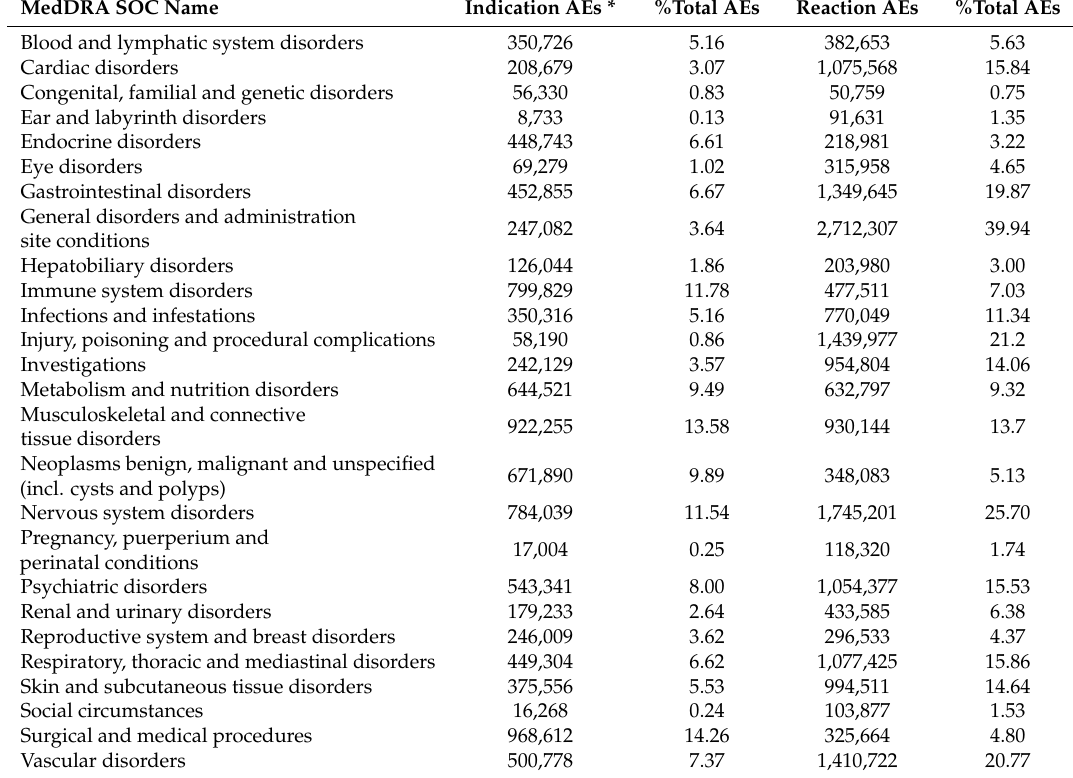
Table 1. FAERS indications and reactions summarized at MedDRA System Organ Class (SOC, level 1) terms. Indication and reaction information from FAERS is not straightforward to interpret, as many cases do not have indications as well as in many cases the reported reactions may refer to similar conditions or may reflect the patient’s disease. * AEs: adverse